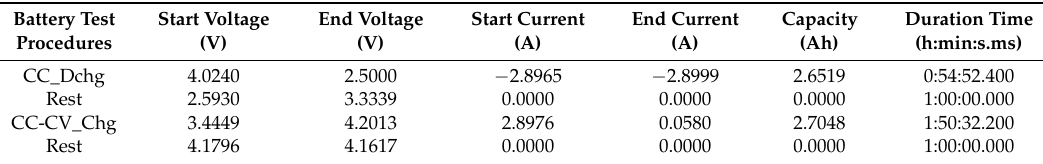
Table 2. Charging and discharging steps of NCR18650PF LIBs.